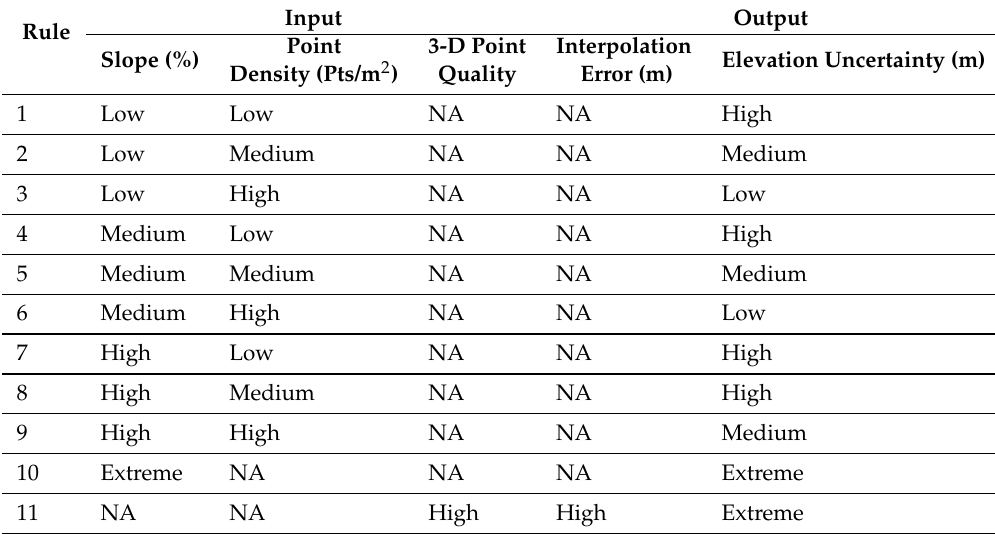
Table 2. A four input fuzzy inference system for elevation